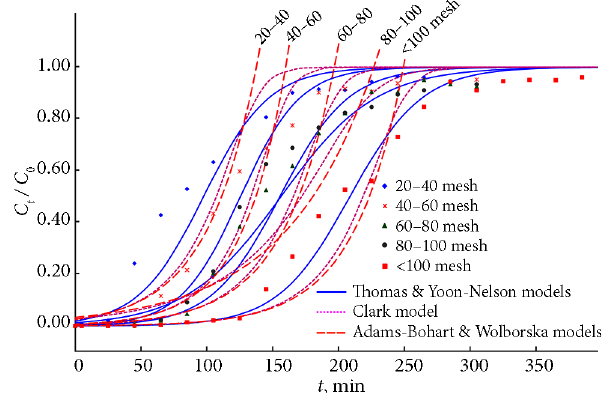
Figure 7. Effect of adsorbent mass on breakthrough curve for As(V) adsorption removal by the PC-Fe/C adsorbent prepared with eucalyptus wood template (influent As(V) concentration: 20 mg/L; flow rate: 5.136 mL/min; pH: 3; adsorbent grain size: <100 mesh; operating temperature: 35 ° C)